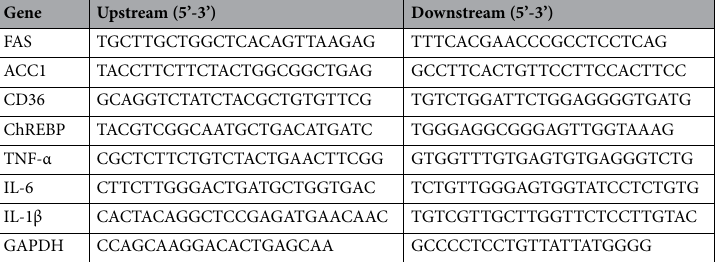
Table 2. Oligonucleotide sequences of